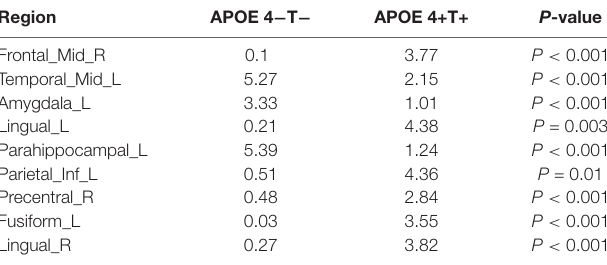
TABLE 6 | Significant differences in the hub regions ( P < 0.05;